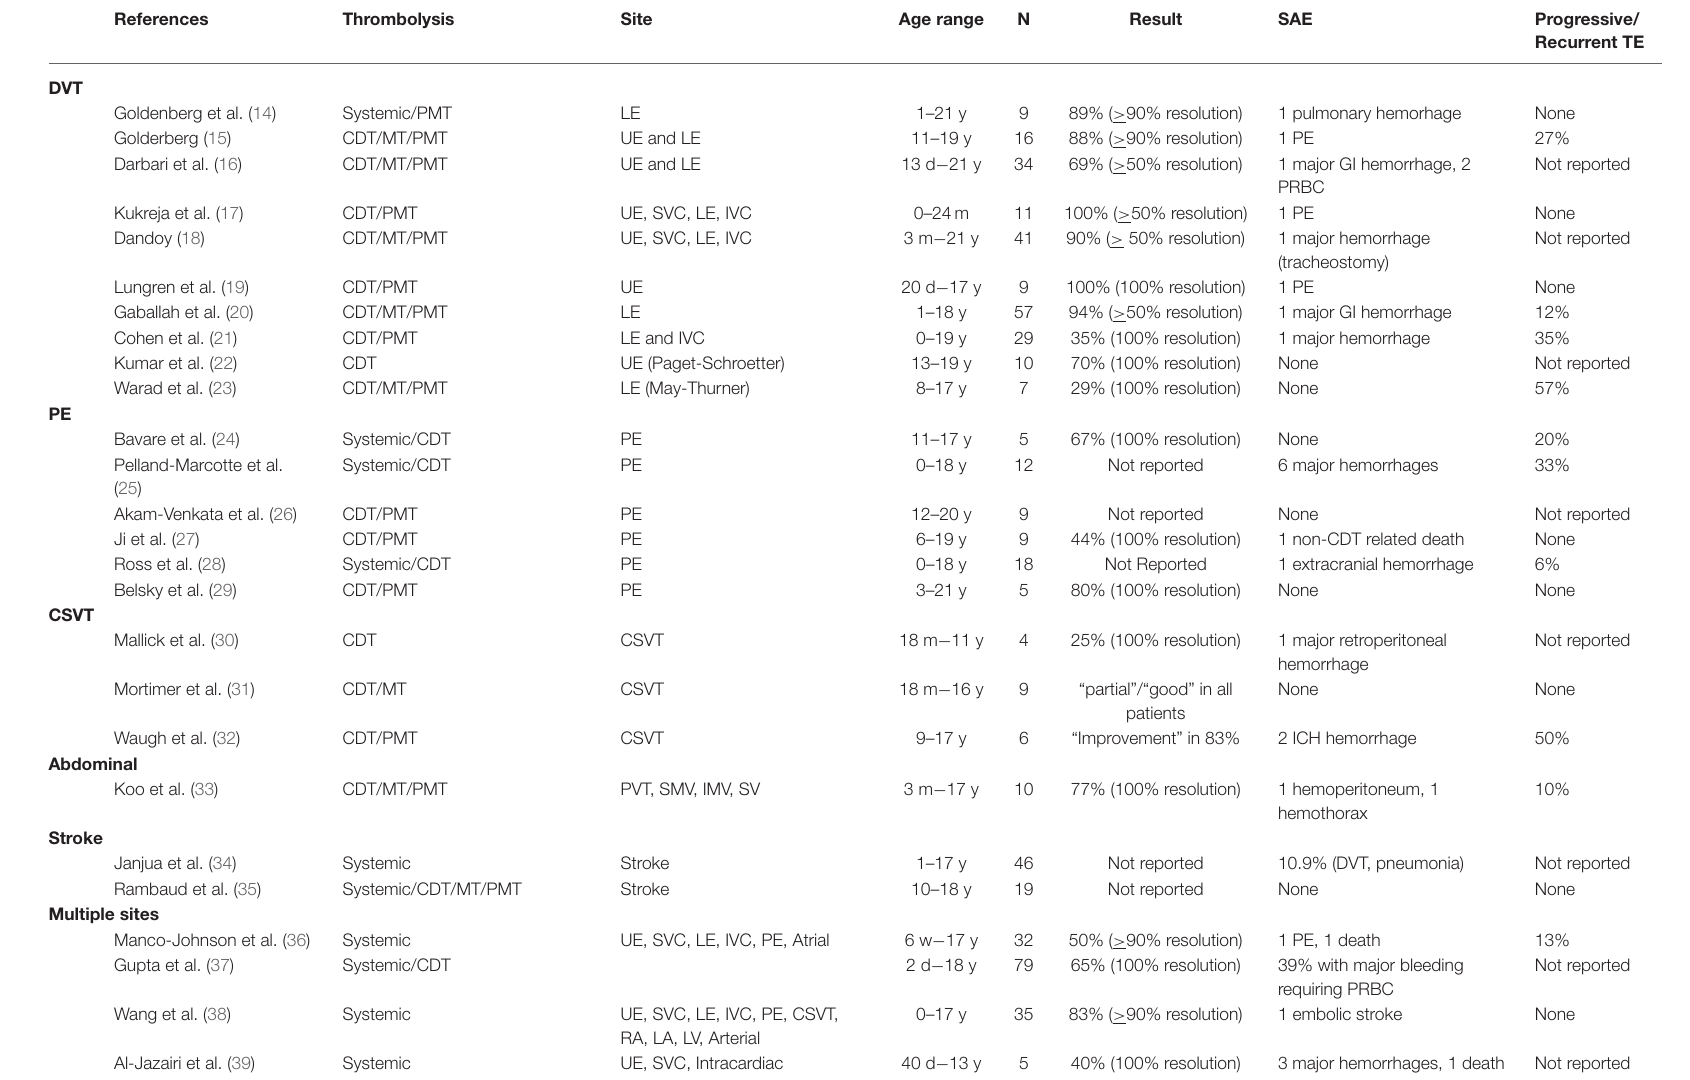
TABLE 1 | Summary of case series and case cohorts on thrombolysis in children based on thromboembolism